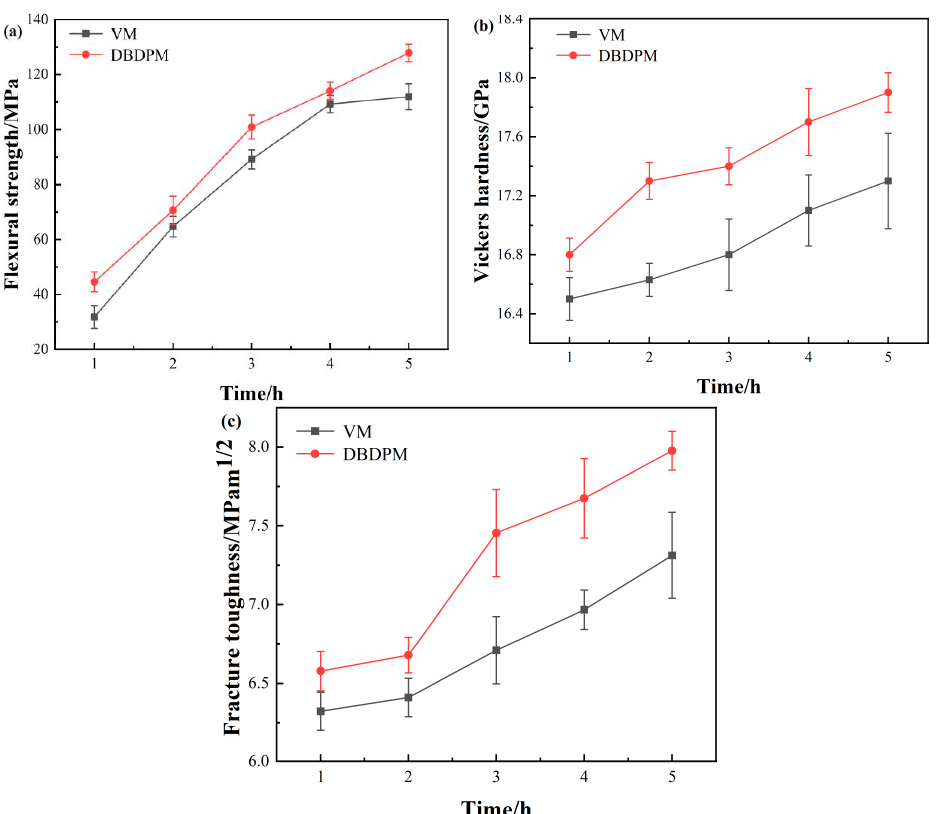
Figure 9. Mechanical properties of Al 2 O 3 ceramics fabricated with various alumina powders: ( a ) flexural strength; ( b ) Vickers hardness; and ( c ) fracture toughness. ural strength; ( b ) Vickers hardness; and ( c ) fracture